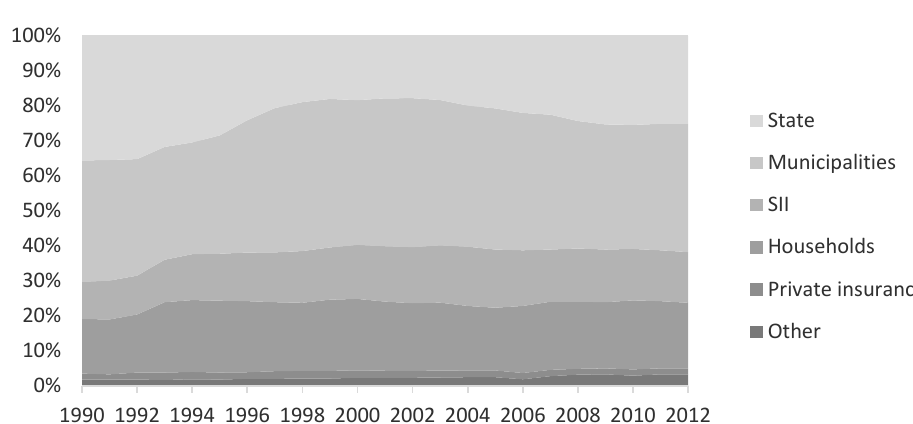
Figure 2: Health care financing by source of revenue 1990-2012